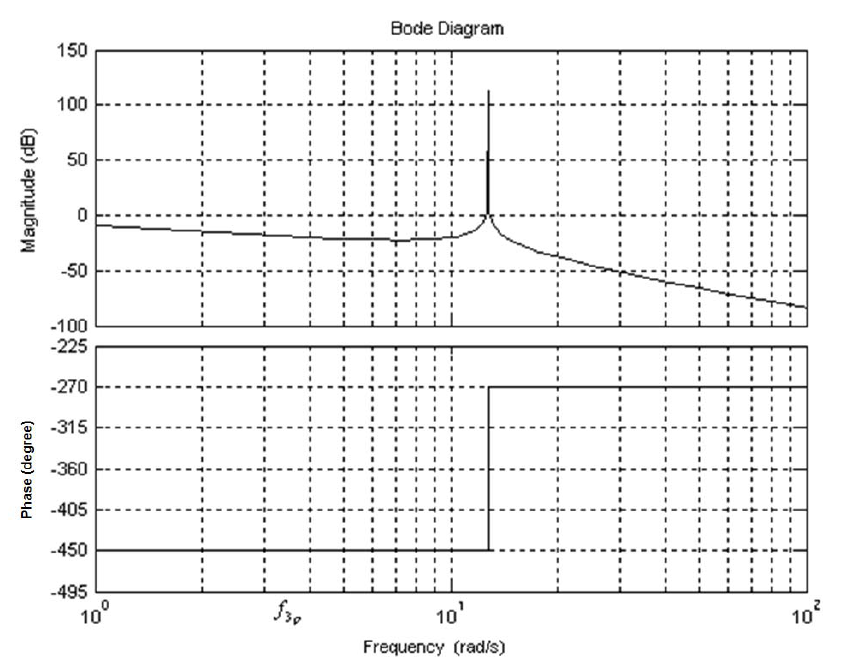
Figure 7. Bode plot of the transfer function between the generator speed and wind turbine